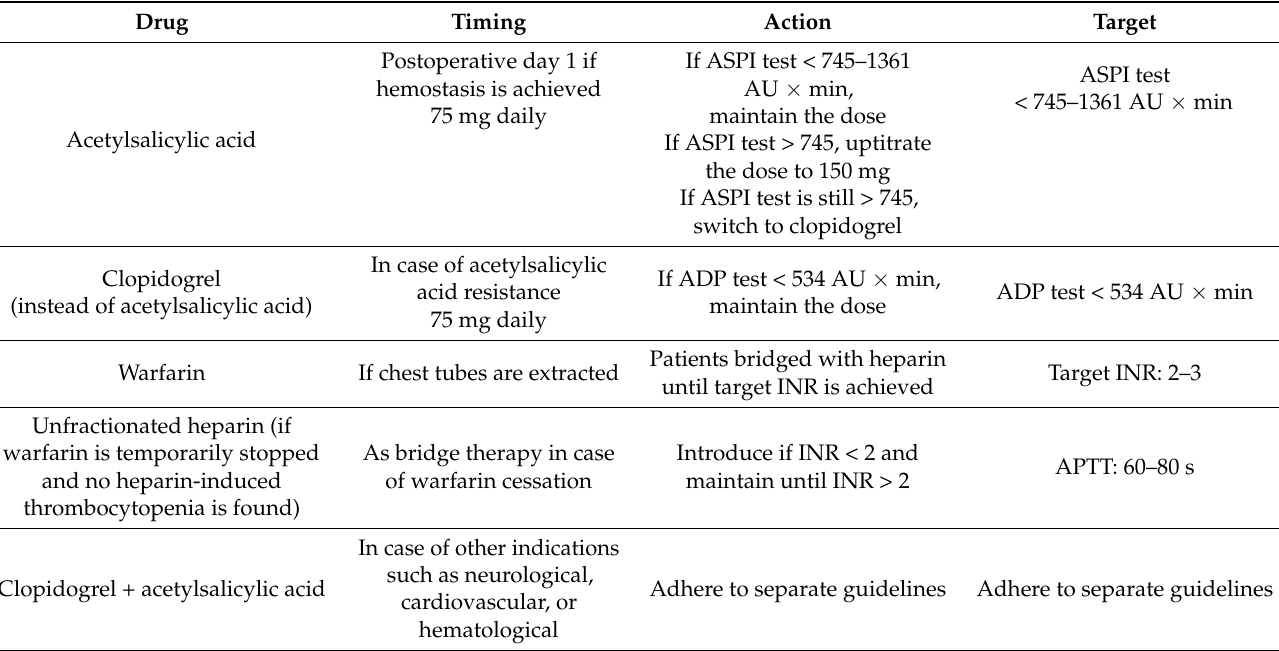
Table 2. Antithrombotic regimen in LVAD patients.